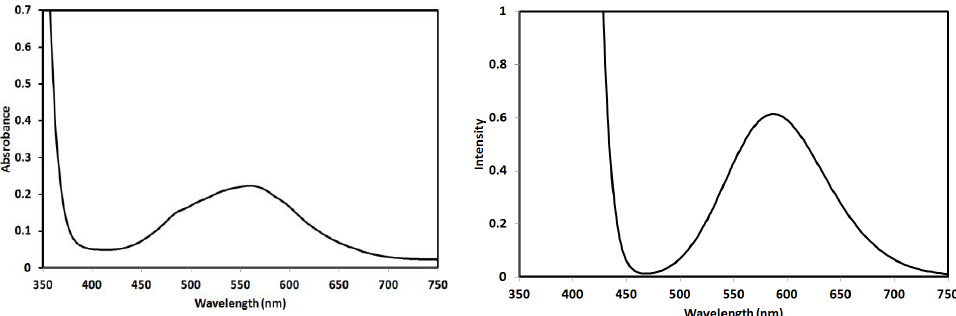
Figure 10. The experimental (left) and calculated (right) electronic spectra of complex 2 .